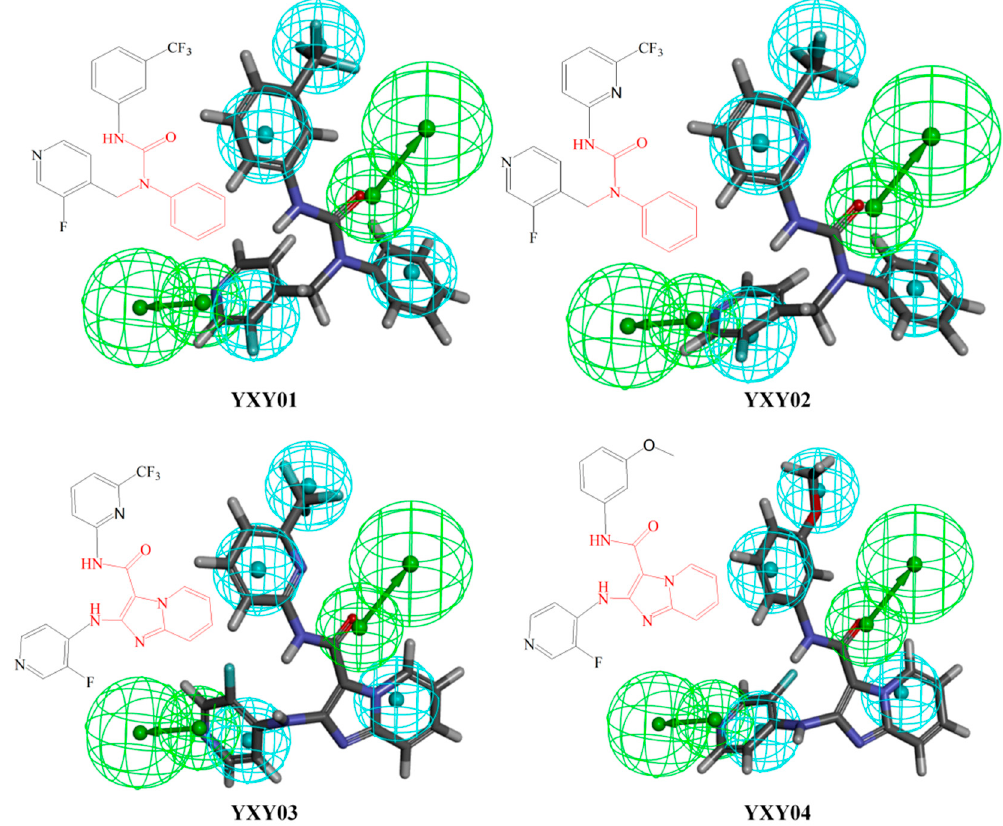
Figure 7. Compounds YXY01–04 obtained by virtual screening using pharmacophore model A02 (hydrogen bond acceptors in green balls; hydrophobic properties in blue balls). Table 3. Parameters of Lipinski’s rule and toxicity prediction of compounds YXY01–04 and BMS22 calculated by DS TOPKAT. MW, molecular weight; ROTB, rotatable bond; HBA, hydrogen bond acceptor; HBD, hydrogen bond donor; DTP, developmental toxicity potential; LOAEL, lowest observed adverse effect level; MTD, maximum tolerated dose; LD 50 , median lethal